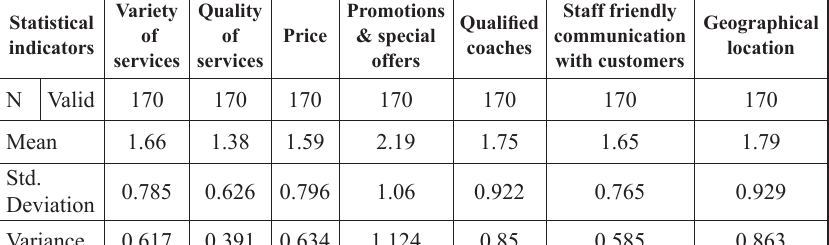
Variety Statistical of indicators